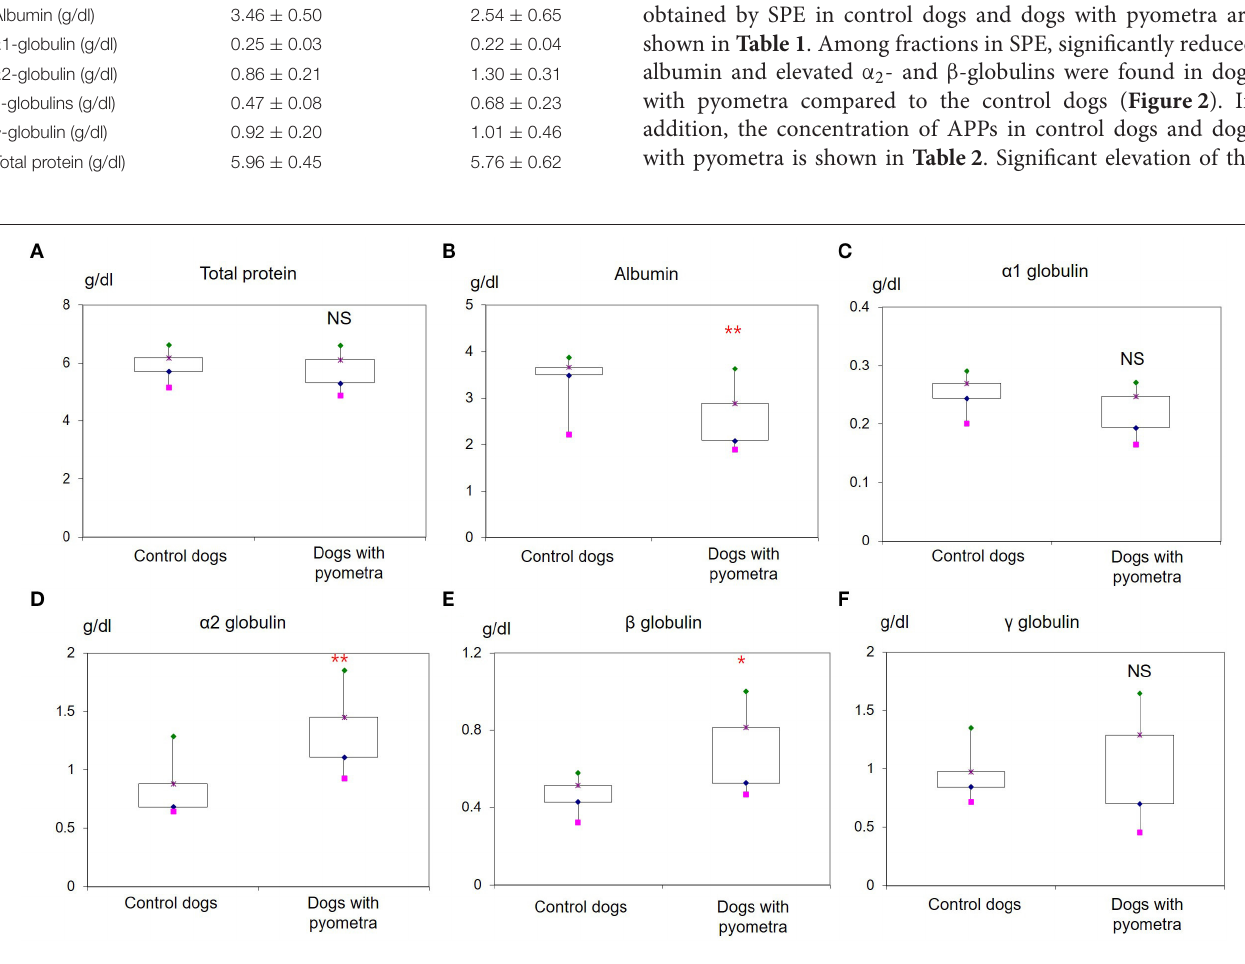
FIGURE 2 | Increased levels of serum proteins in dogs with pyometra separated by serum protein electrophoresis. Significantly reduced levels of albumin (B) and elevated levels of α 2 -globulin (D) and β -globulin (E) were observed in dogs with pyometra compared to the control dogs. Meanwhile, no significant difference was found in the levels of total protein (A) , α 1 -globulin (C) and γ -globulin (F) . NS: no significant difference; * P < 0.05; ** P <